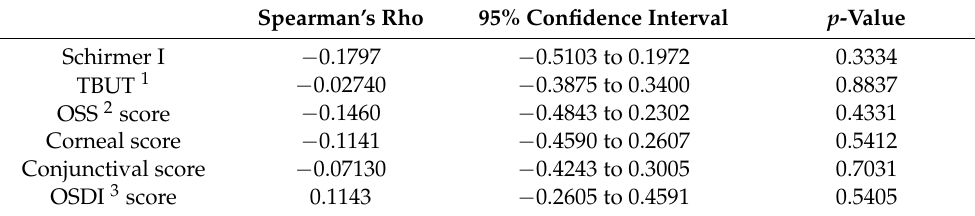
Table 3. Correlations of tear ATG5 with the Schirmer I, tear breakup time, ocular surface staining score, and ocular surface disease index in non-Sjögren syndrome dry eye disease patients.